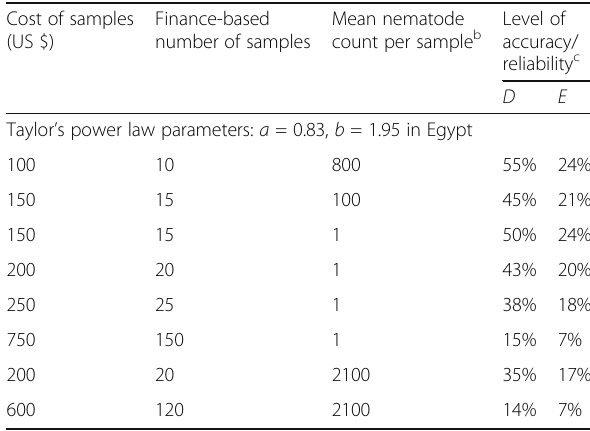
Table 4 Percentage level of accuracy as defined in terms of the standard error to mean ratio ( E ) and the ratio of the half-width of the confidence interval a to the mean (D) for stratified random sampling of Tylenchulus semipenetrans in citrus orchards of Egypt (Abd-Elgawad 2017) Cost of samples Finance-based Mean nematode Level of (US $) number of samples count per sample b accuracy/ reliability c